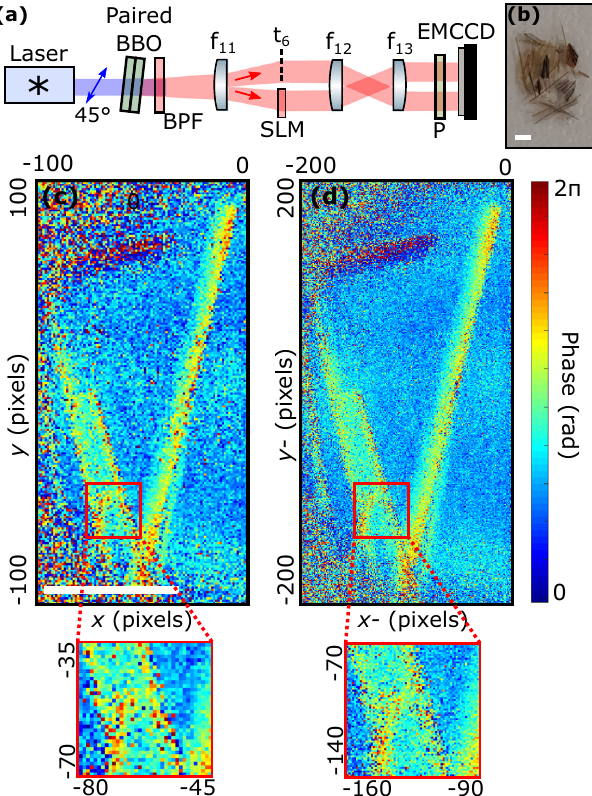
Fig. 4 Results in entanglement-enabled quantum holography. a Experimental setup. Light emitted by a laser diode at 405 nm and polarized at 45 ∘ illuminates a stacked BBO crystal pair (0.5 mm thickness each) whose optical axes are perpendicular to each other to produce pairs of photons entangled in space and polarization by type-I SPDC. After the crystals, pump photons are fi ltered out by a band pass fi lter at 810 ± 5 nm. A lens f 11 is used to Fourier-image photon pairs onto an optical plane where an SLM with a phase object t 6 . A two-lens imaging system f 12 − f 13 is then used to image the SLM and the object onto two different parts of an EMCCD camera. A polarizer (P) at 45 ∘ is positioned before the camera. The biphoton correlation width in the camera plane is estimated as σ ≈ 9 μ m. EMCCD camera pixel pitch is 16 μ m. b Photo of the birefringent object used in the experiment (section of a bird feather). c Spatial phase of the object reconstructed by combining four anti-diagonal images Γ ij − i − j measured for four phase shifts {0, π /2, π /2, 3 π /4} programmed by the SLM. d Spatial phase of the same object reconstructed from four minus-coordinate projections P − . White scale bar is 1